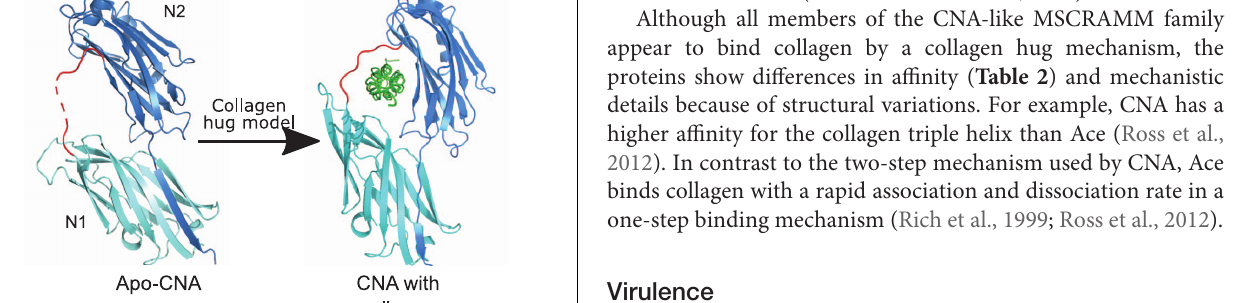
preferentially to cleaved collagen in damaged or inflamed tissues (Madani et al., 2017).